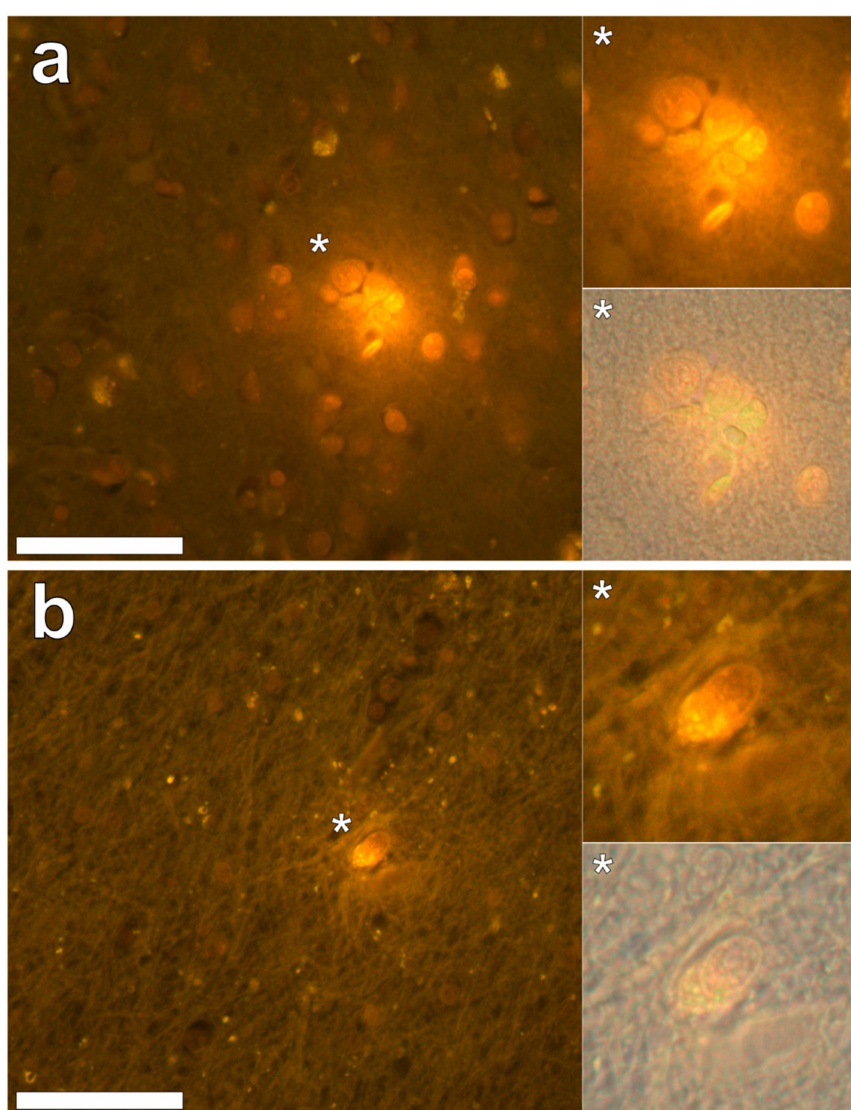
Figure 6. Intracellular lumogallion-reactive aluminium in glial cells in grey and white matter of the occipital lobe. Cells morphologically compatible with microglia surrounding astrocytes ( a ) and an aluminium loaded astrocytic-like cell, exhibiting intracellular bright orange fluorescence ( b ), were identified in grey and white matter regions, respectively. Magnified inserts are denoted by asterisks with lower panels including a bright field overlay. Magnification 400 × ; scale bars 50 µ